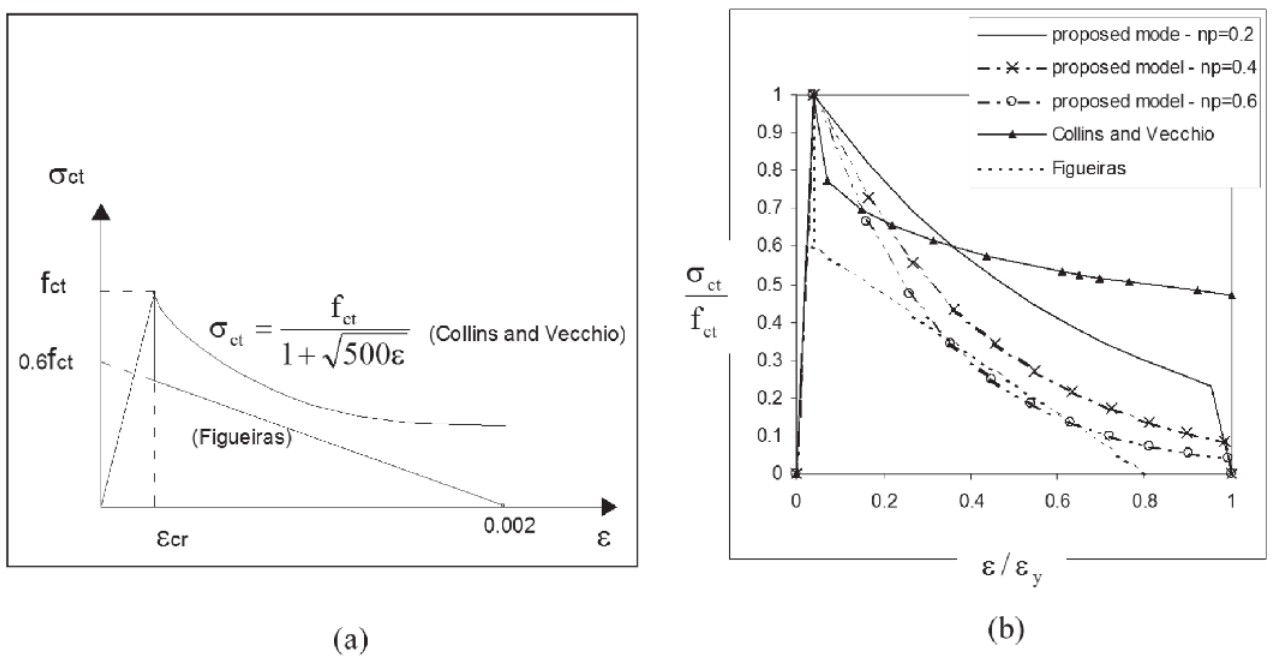
Figure 2 Comparison of tension-stiffening models: (a) Collins and Vecchio [14] and bi-linear model [26]; (b) Simplified models and the proposed model for different values of n